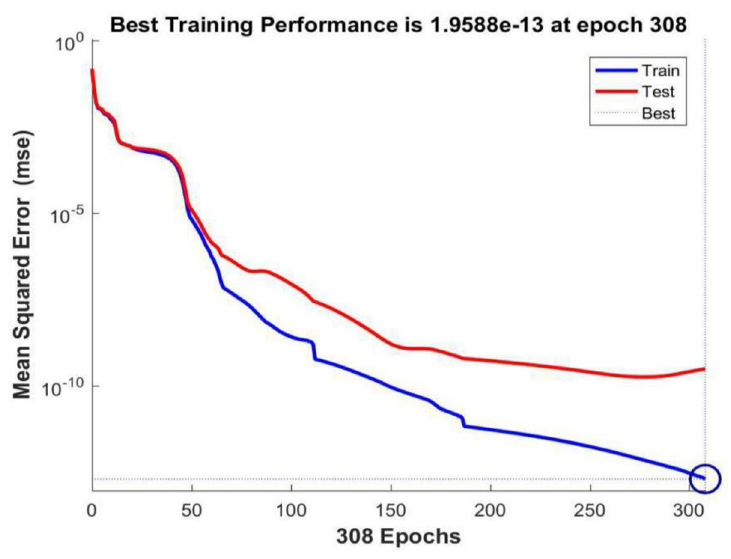
Fig 10. Trainbr performance graph.